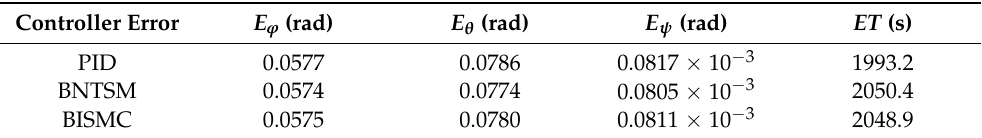
Figure 6. Wind speed estimation, in Scenario 1 with wind.